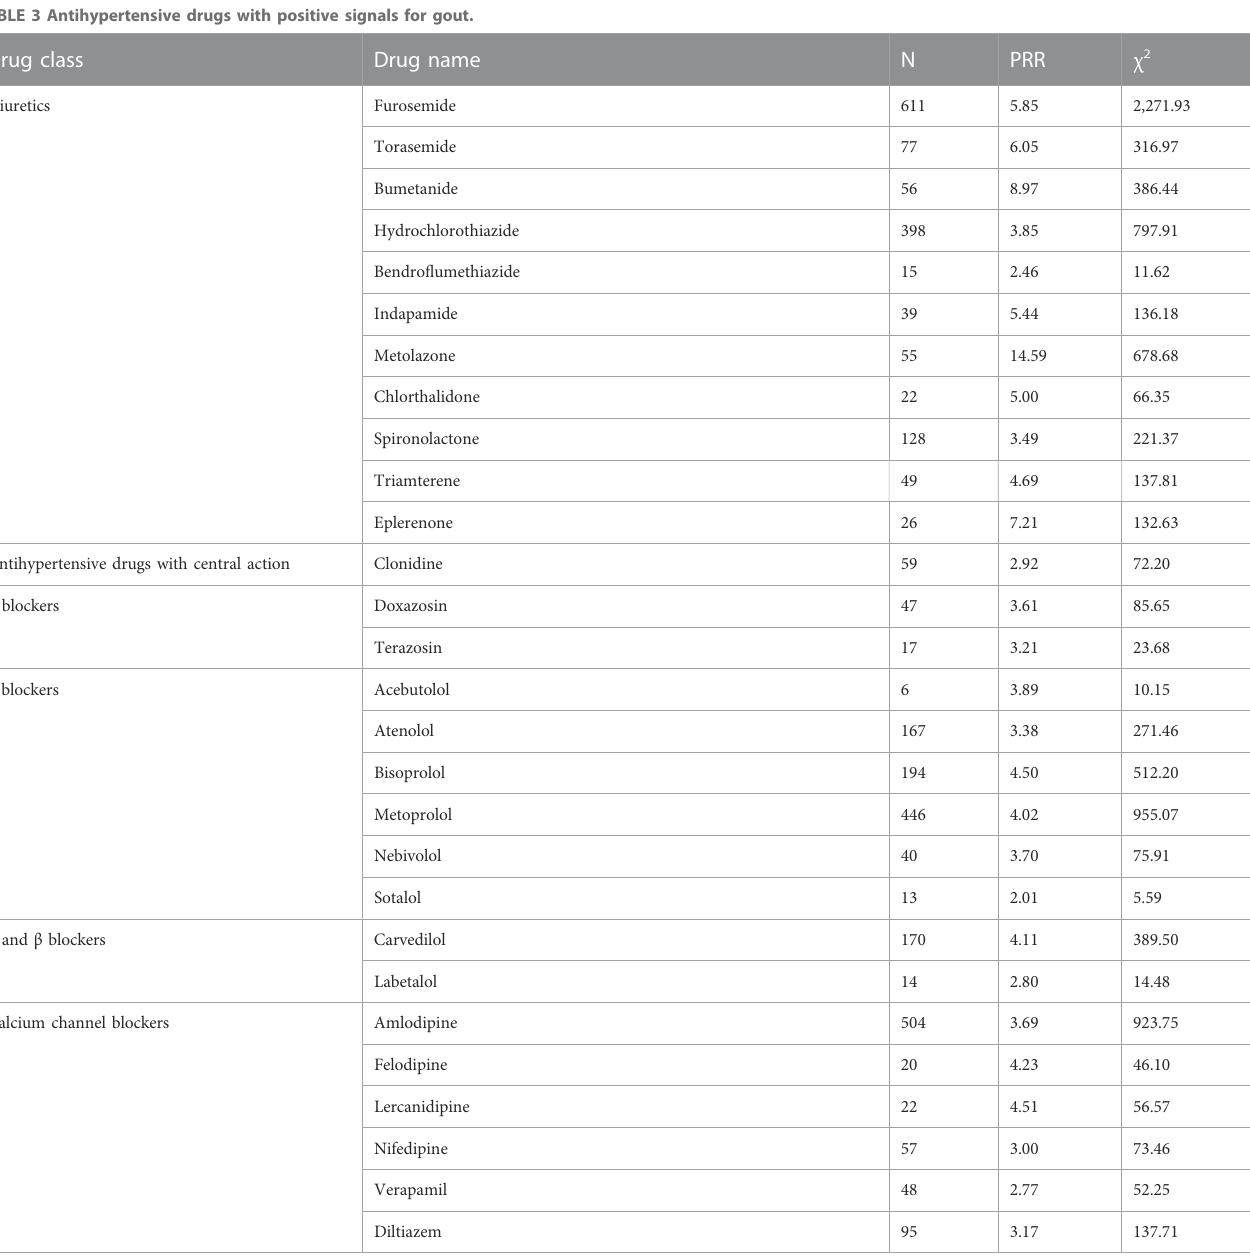
TABLE 3 Antihypertensive drugs with positive signals for